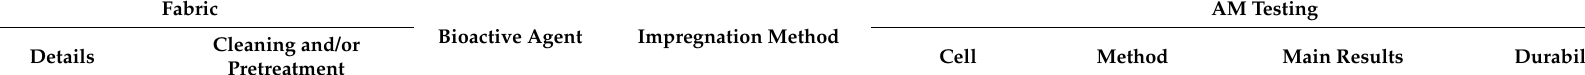
Table 1. Recent trends (2020–2022) in antimicrobial protective textiles designed for military purposes or for general